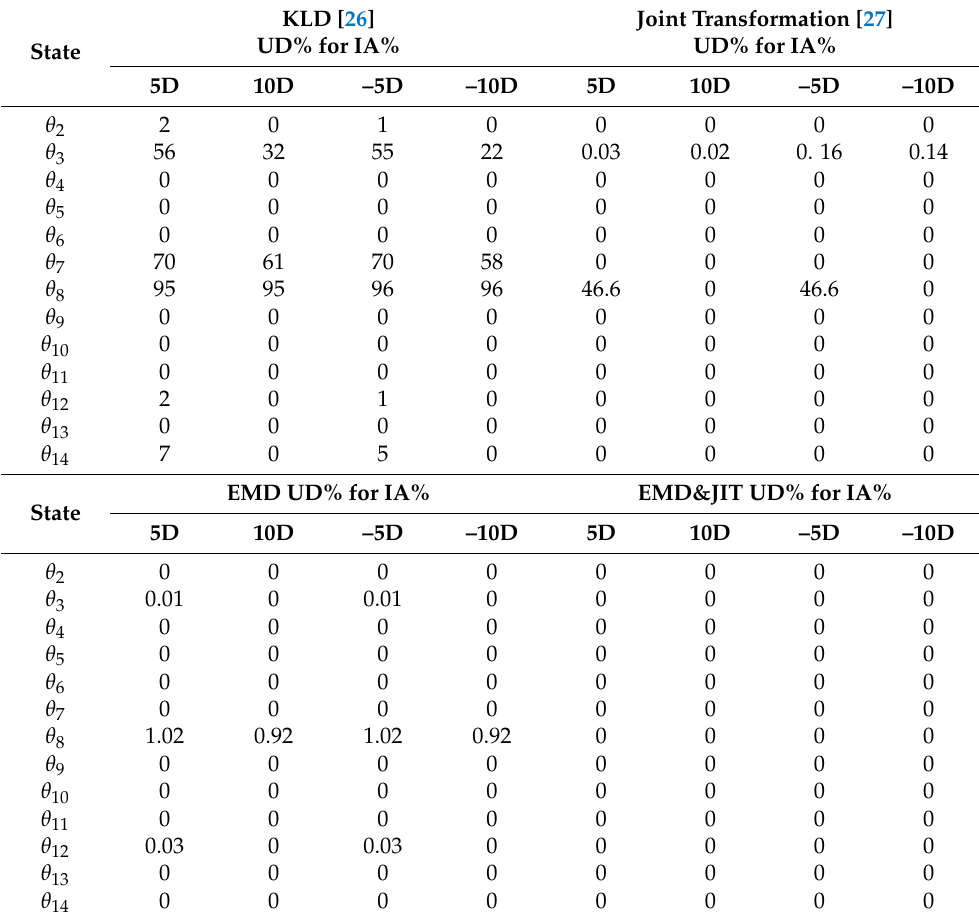
Table 2. FDIAs test results for each